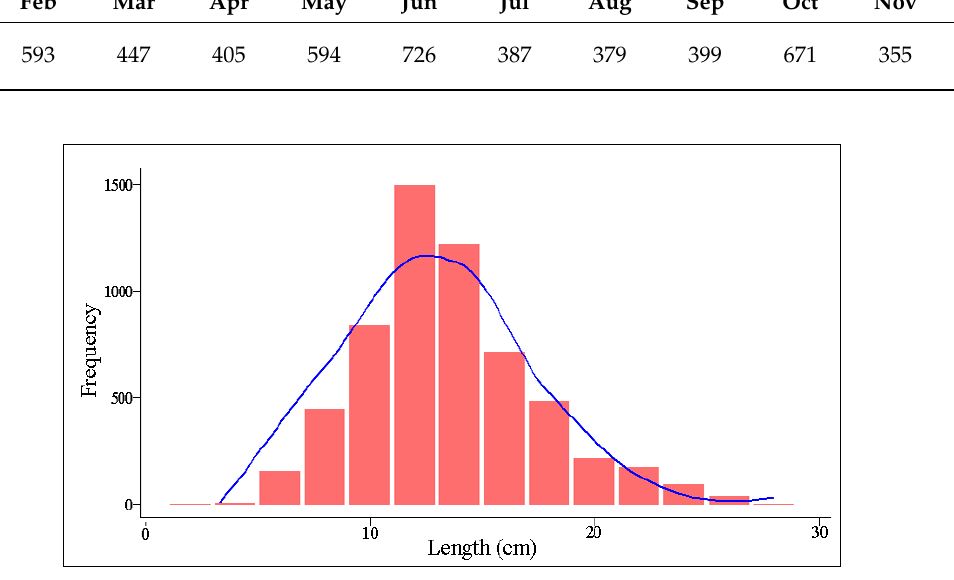
Figure 4. The bar chart shows the length–frequency, and the curve shows the unimodal distribution of the size data of the Bombay duck based on the data collected during this study (from January to December 2018). December